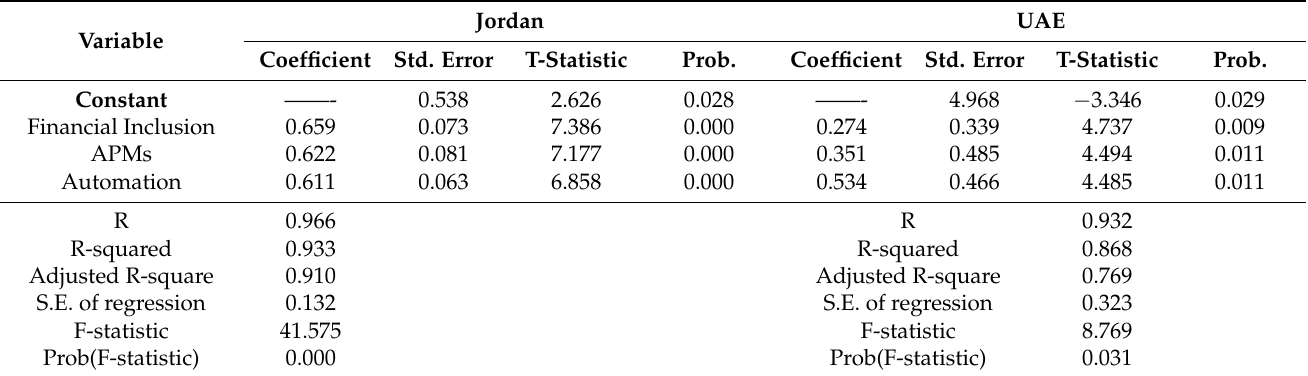
Table 10. Results of Multiple Regression Test for the Second